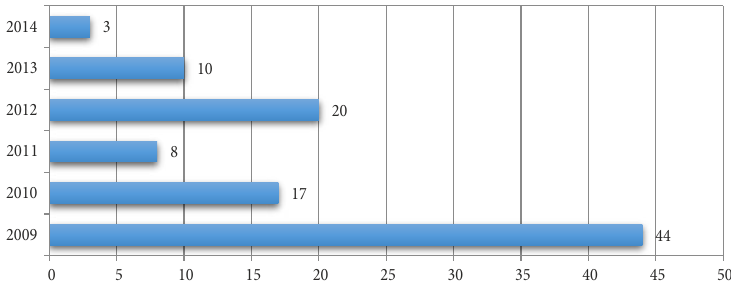
Fig. 5. Structure of respondents by the introduction of the local